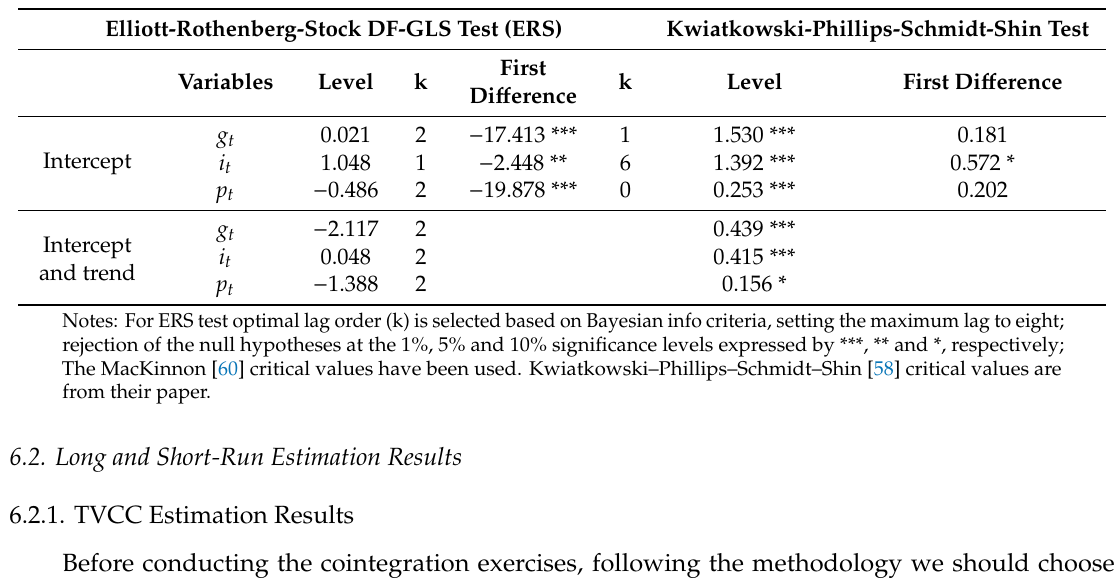
Figure 2. Plots of the di ff erenced variables. notes: dg, di and dp are di ff erenced gasoline demand and income, both in per capita terms, and real gasoline price, respectively. d is di ff erence operator.